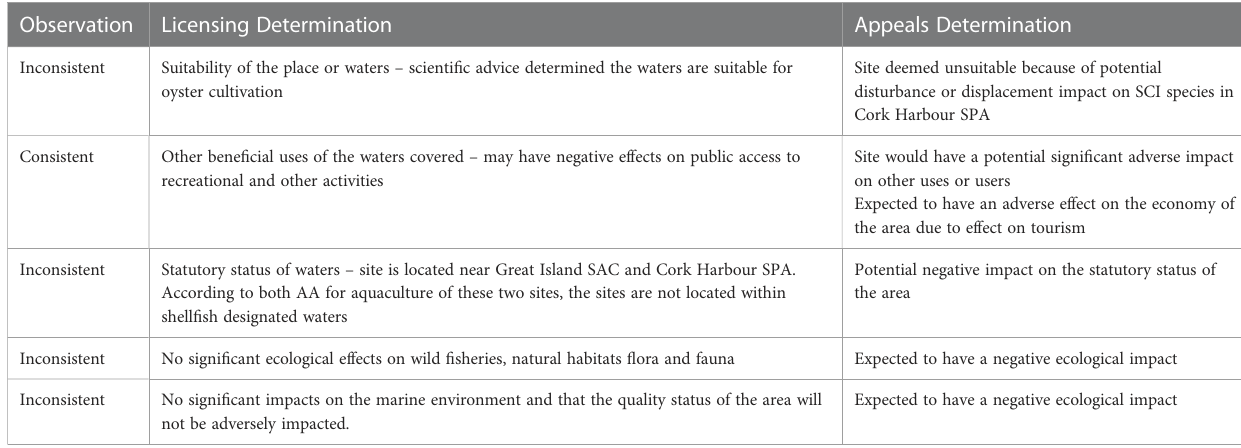
TABLE 4 Licence and appeal for an oyster cultivation site in spike island.